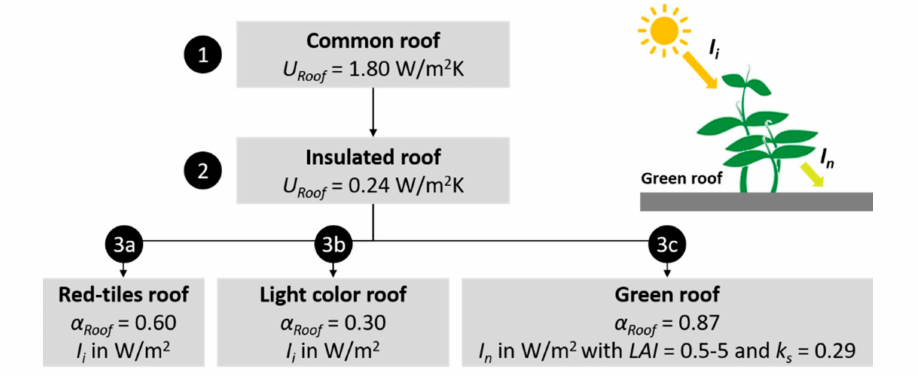
Figure 4. Energy e ffi ciency solutions’